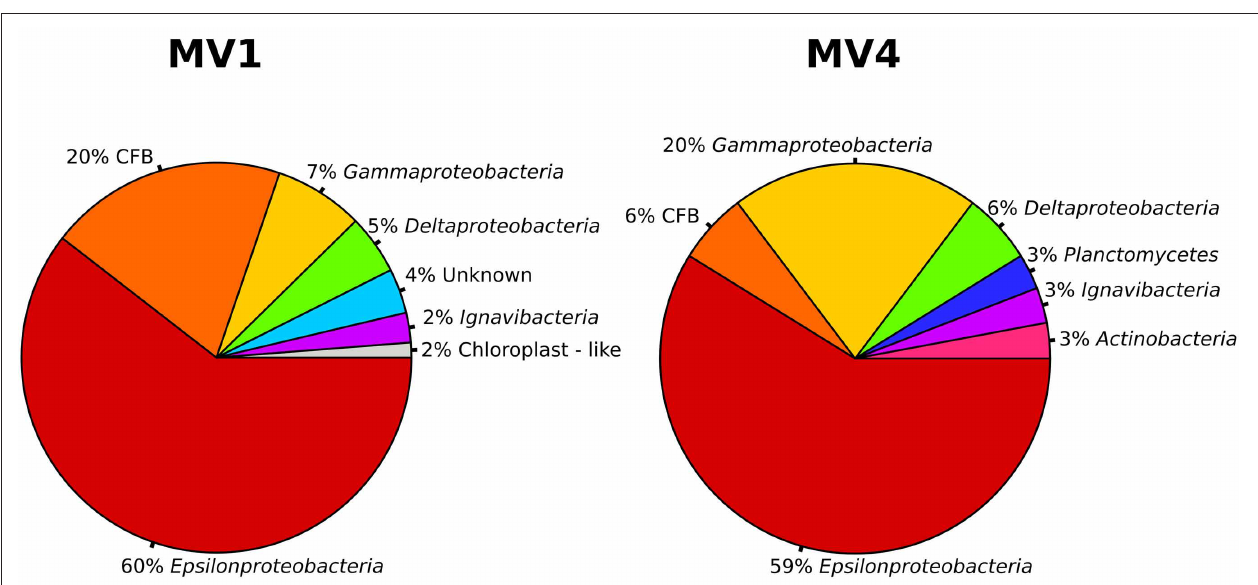
FIGURE 4 | Bacterial community structure at station MV1 and MV4 surface sediments (0–1cm) as obtained by the analysis of the sequences. Groups are shown at the phylum level based on the results of BLAST and position on the phylogenetic tree. CFB, Cytophaga - Flavobacteria - Bacteroides group.